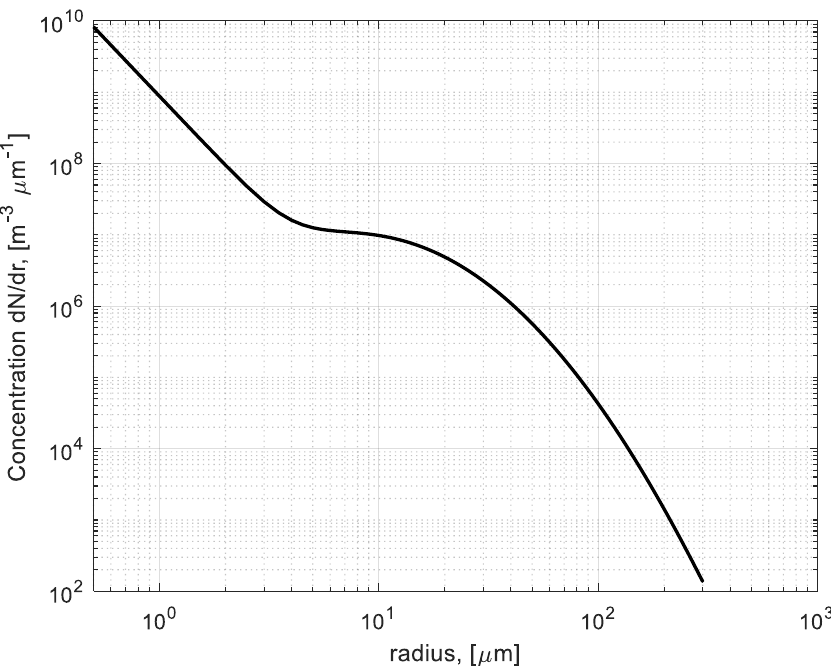
Figure 4. Particulate number distribution (m −3 μm −1 ) for the brownout model adopted from [21]. Total particle concentration fixed at N total = 5 × 10 9 m −3 .